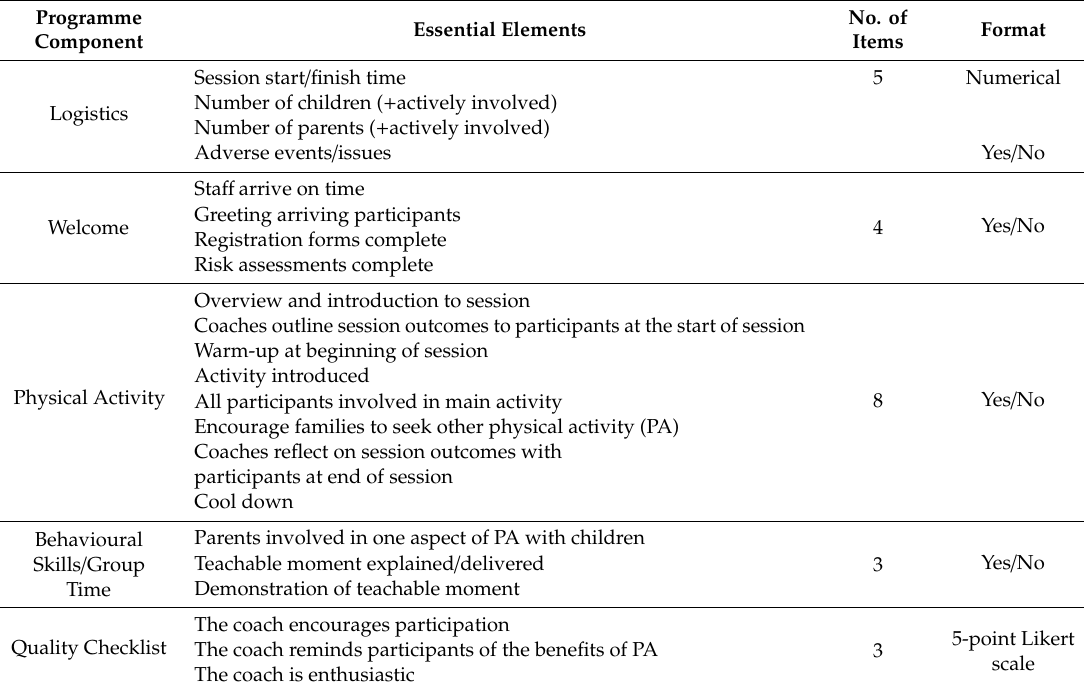
Table 2. Description of observation record form for assessing fidelity of